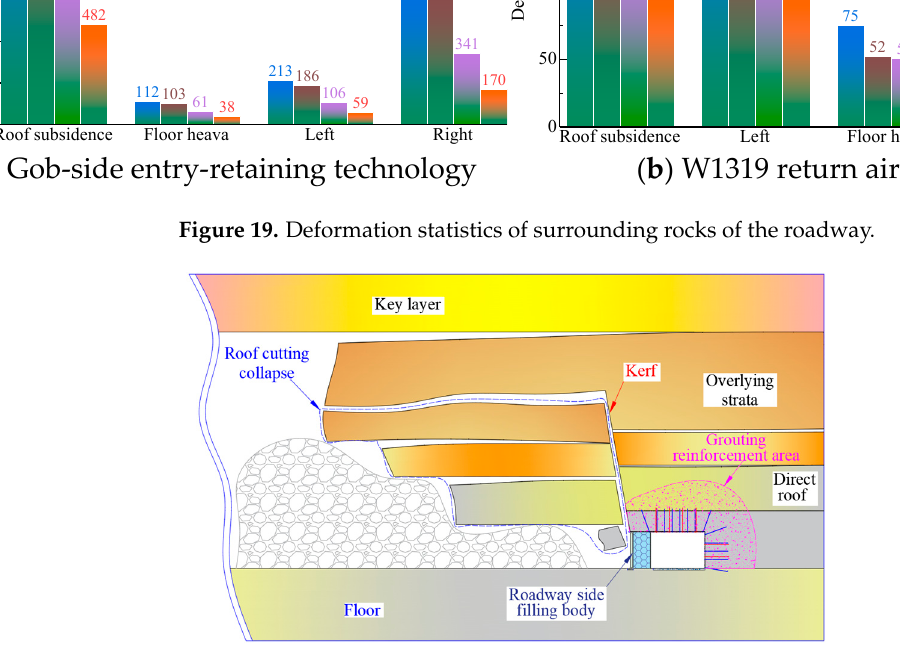
Figure 21. Position calibration of mine pressure monitoring. The field measurement results are shown in Figure. 22 and Figure. 23, When the mon- itoring station is 40 m away from the working face, the surrounding rocks of the gob-side entry-retaining technology are activated to have severe deformation due to the influence of mining and advanced stress in the mining process of the working face. The deformation rate of the surrounding rocks of the roadway reaches the maximum at about 6 m in front of the working face. The maximum roof-to-floor deformation rate is 71 mm/d; the maxi- mum roof-to-floor approach is 418 mm; the maximum roof subsidence is 302 mm; the maximum two-side approach rate is 44 mm/d. The deformation on the coal-pillar side is much larger than that of the roadside backfill. The maximum two-side approach is 334 mm, and the maximum deformation of the coal pillar side is 253 mm.